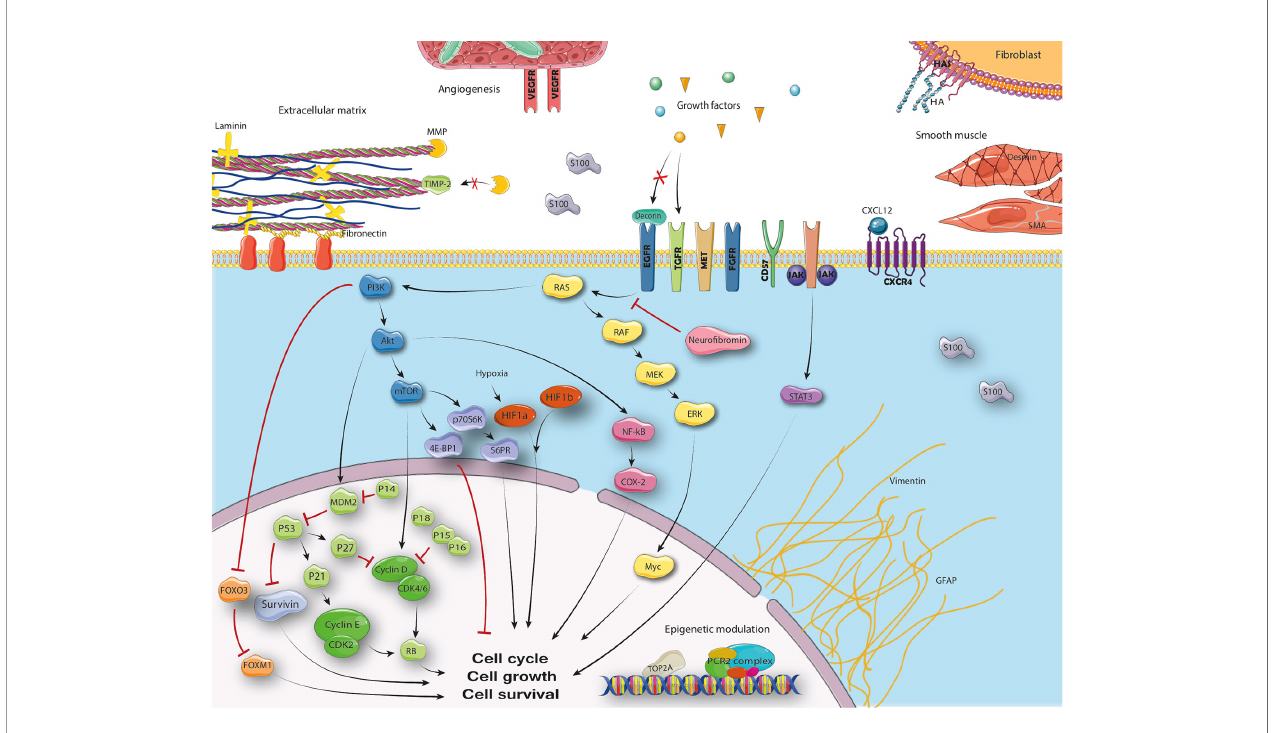
FIGURE 2 | Cellular pathways in